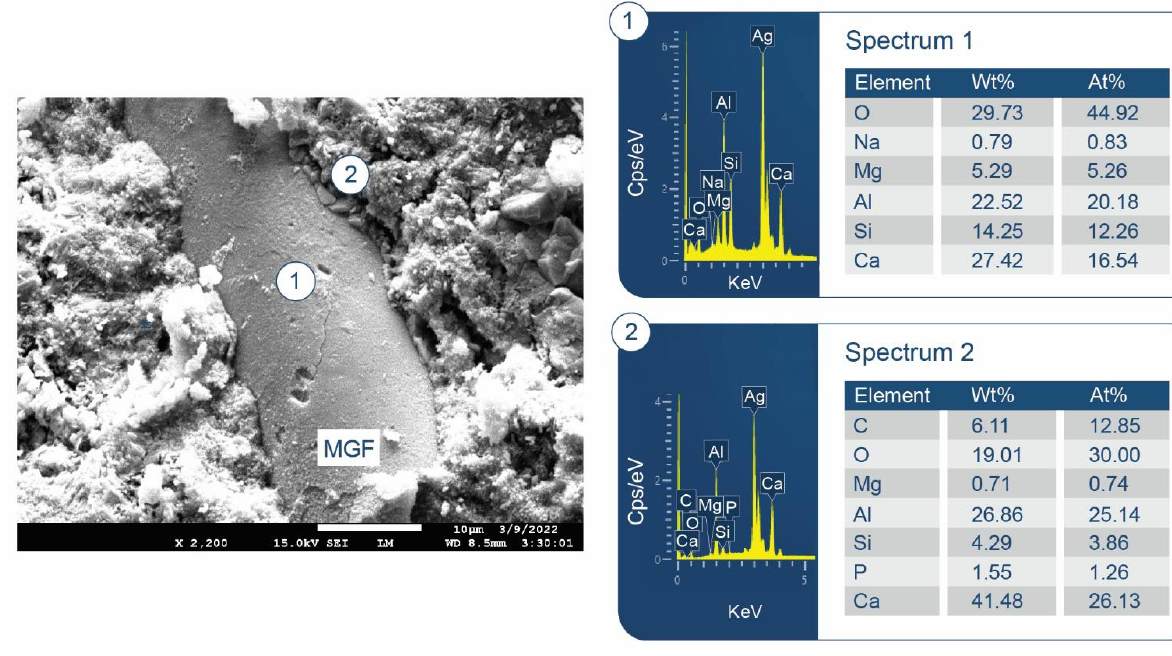
Figure 20. Photomicrograph of MGF of 250 °C-autoclaved Ca/MGF cement.